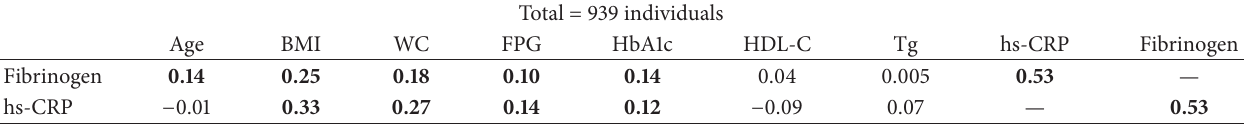
Dependent variables are listed vertically, and covariates are listed horizontally. Cells show univariate correlation coefficients (significant in bold = 𝑃 ≤ 0.05 ). BMI: bodymass index; WC: waist circumference; FPG: fasting plasma glucose; HbA1c: glycosylated hemoglobin; HDL-C: high-density lipoprotein cholesterol;